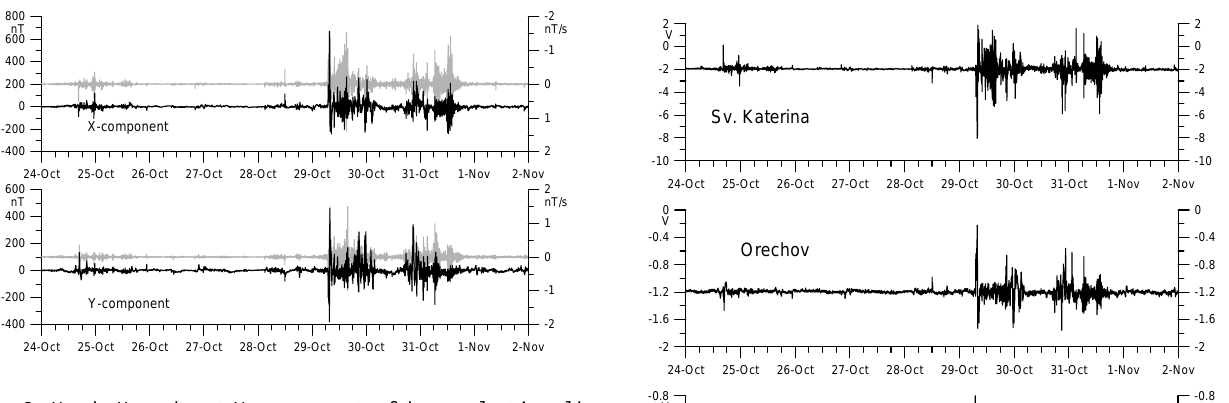
Fig. 3. North, X, and east, Y, components of the geoelectric field computed by the plane-wave model using data from the Observa- tory Budkov (black lines) and corresponding time derivatives of the geomagnetic field (shadow lines). The sampling rate is 1min.